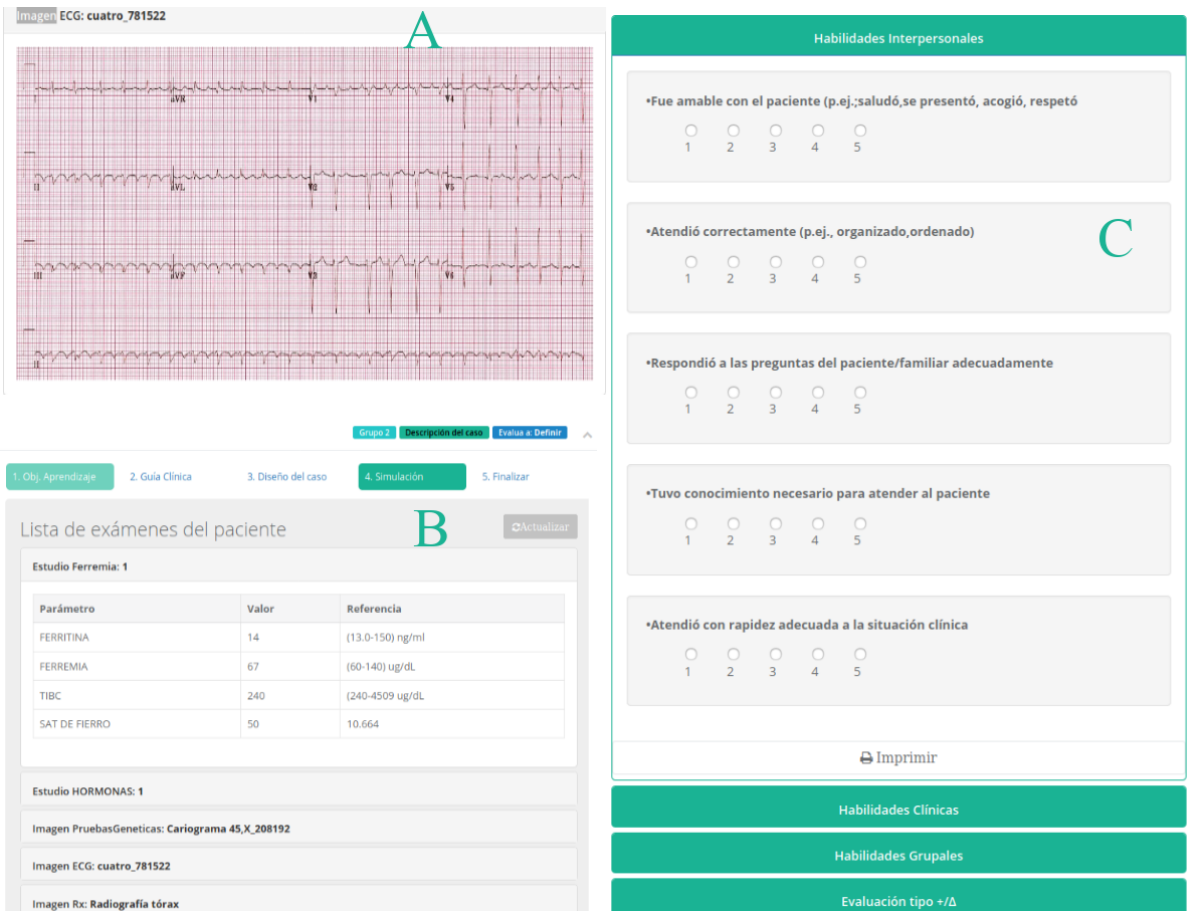
Figure 8. Collaborative simulation module. (A) and (B) are views of the performer group during the collaborative clinical simulation where an electrocardiogram and laboratory test are shown, respectively. (C) is a view of the assessment tool available for the evaluation of the performer group by the evaluator group. In the web platform, there are rubrics previously defined by the teacher that allow for assessment of the performance of the performer group in the